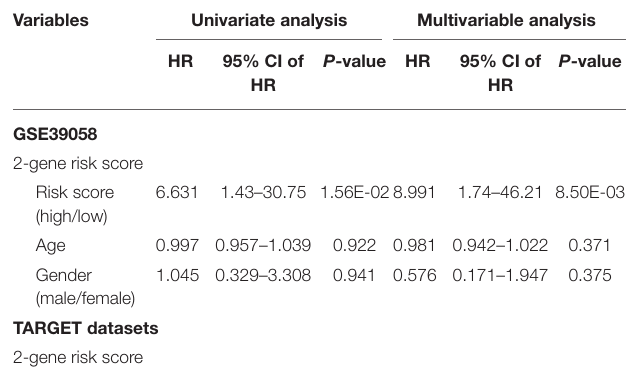
TABLE 1 | Univariate and multivariate cox survival analysis in the training GSE39058 and two external datasets (TARGET database and GSE21257).